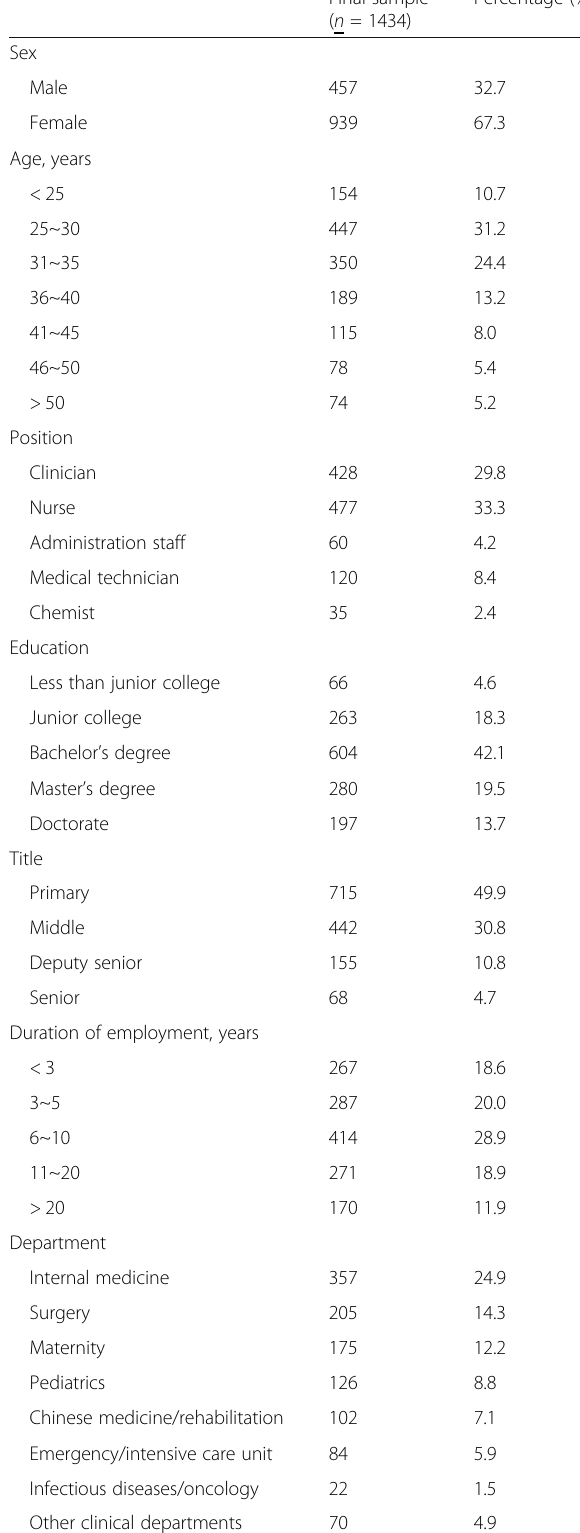
Table 1 Demographic characteristics of the participants